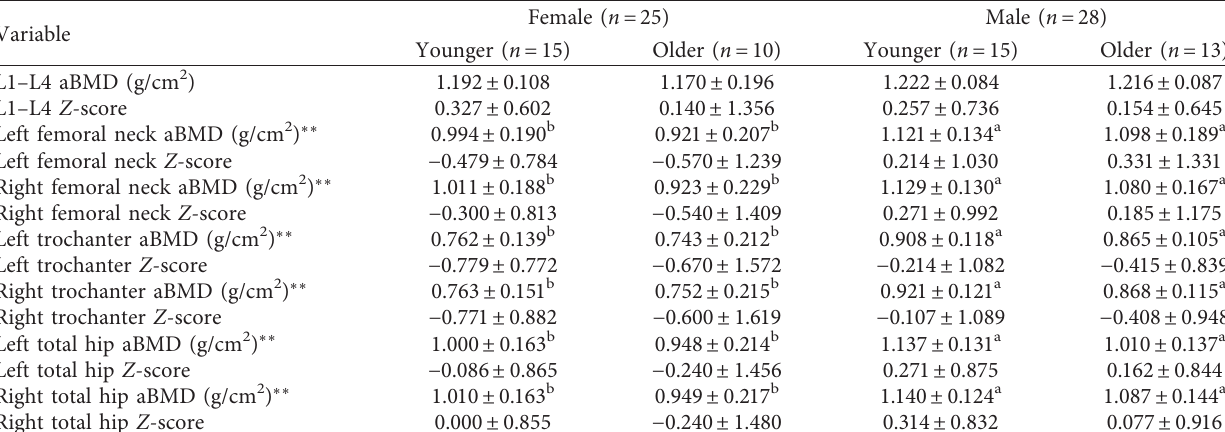
Table 3: Regional areal bone density (mean ± SD).